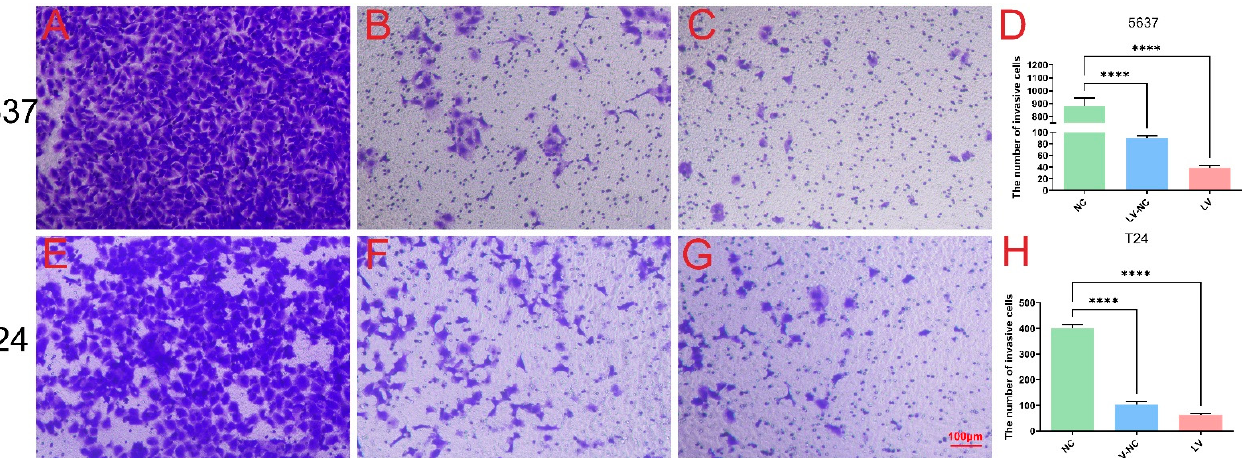
Figure 4. The Transwell migration assay of three groups (transfection group, LV; negative control group, LV-NC; blank group, NC) in 5637 cells ( A – D ) and T24 cells ( E – H ). * indicates p -value < 0.05. **** indicates p -value < 0.0001. Figure 5. The scrape motility assay of two groups in 5637 and T24 cell lines (transfection group, LV; negative control group, LV-NC). ** indicates p -value < 0.01. *** indicates p -value < 0.001.